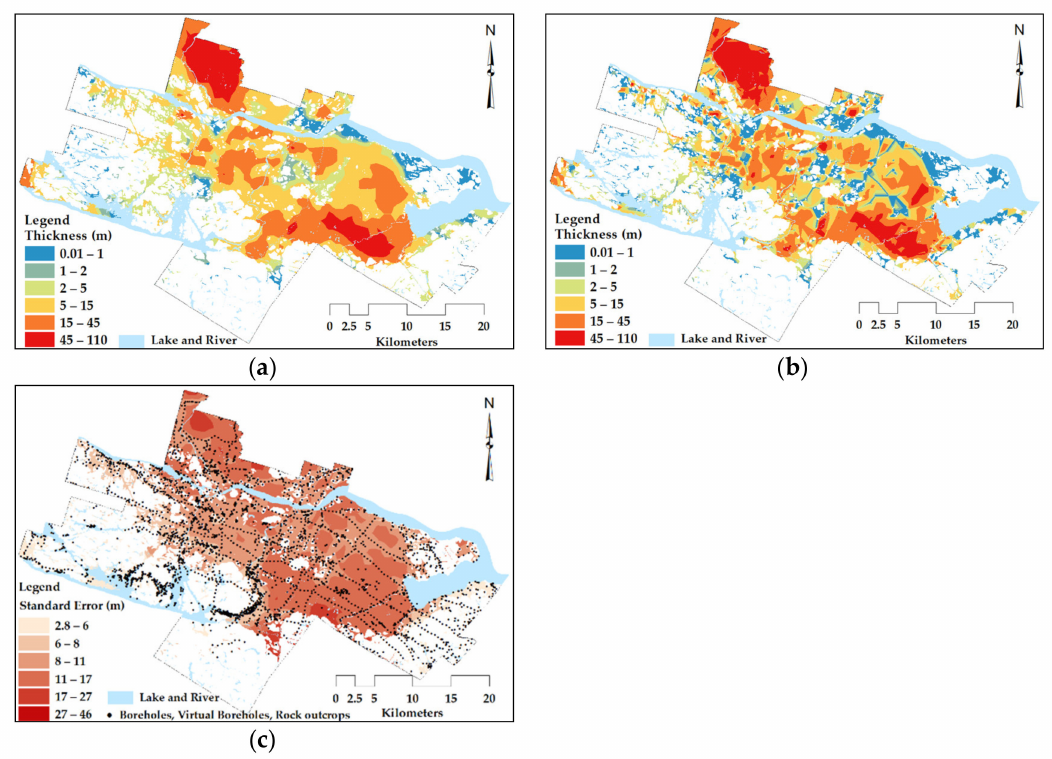
Figure 9. Total soil thickness maps obtained with: ( a ) EBK, ( b ) TIN; and ( c ) the map of the kriging standard deviation ( (cid:101) σ EBK. The areas with till or rock outcrops are excluded and indicated with white